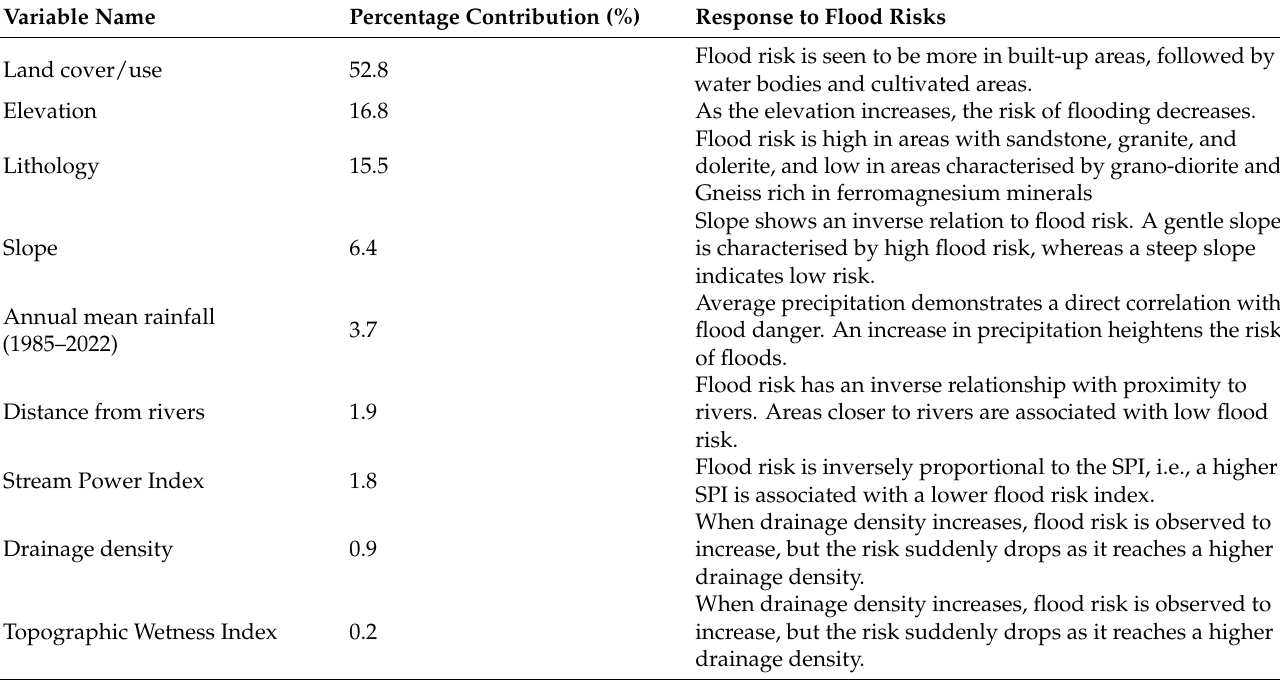
Table 3. Contribution and response of environmental variables to flood